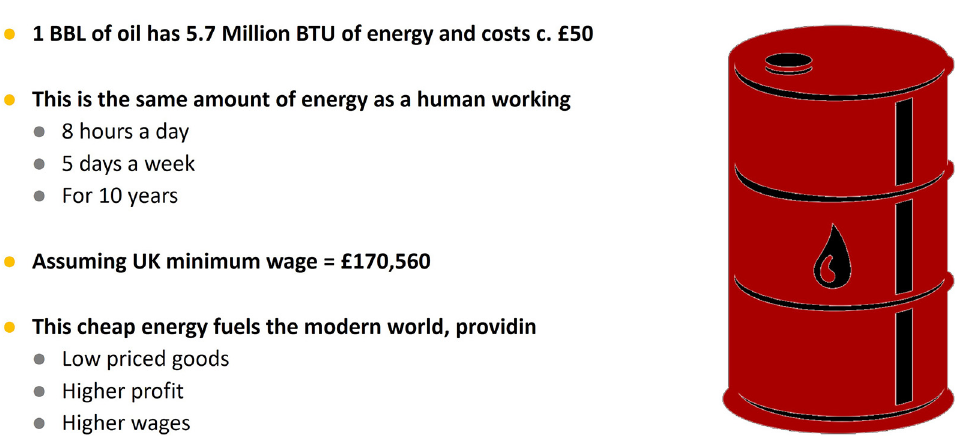
Fig. 11. – The real value of a barrel of oil (Courtesy of Mike Simmons, Haliburton